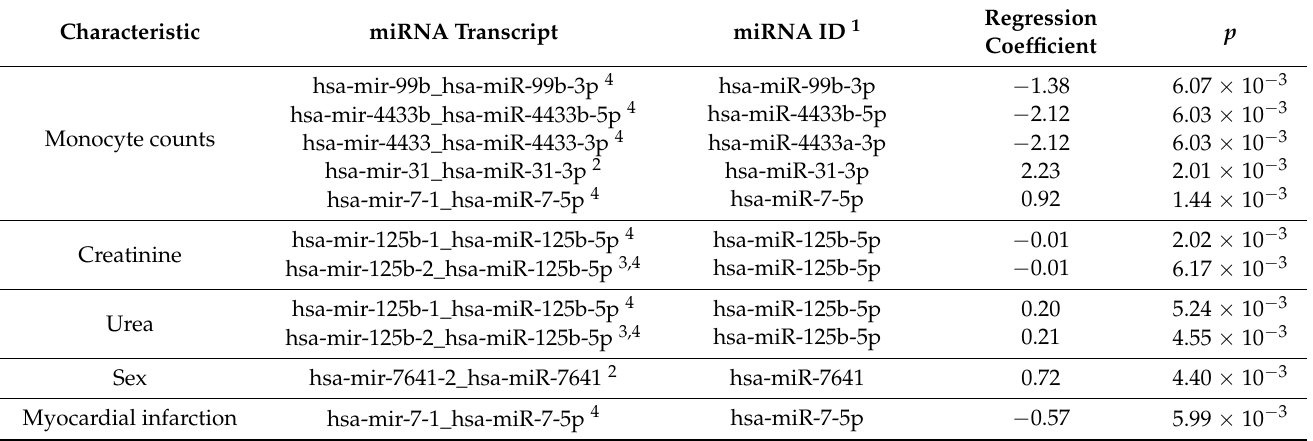
AAA vs. CVD comparison, p —statistical significance, LEAD—lower extremity artery disease, AAA—abdominal aortic aneurysm, CVD—chronic venous